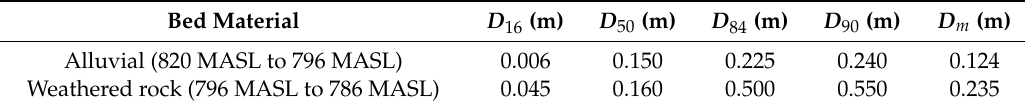
Figure 1. Paute-Cardenillo Dam ( a ) Three-dimensional view; ( b ) Scheme of scour. Table 1. Particles characteristic size of the bed